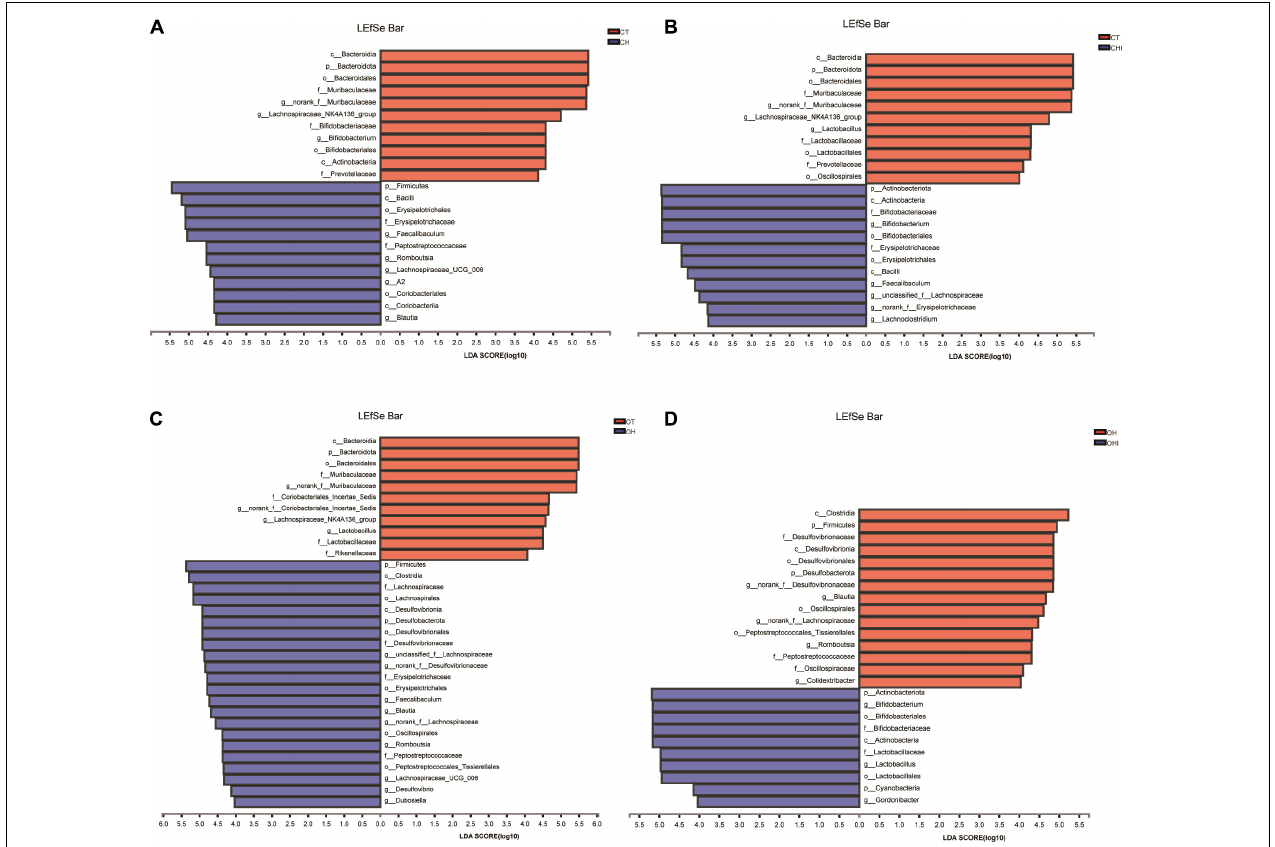
FIGURE 5 | Linear discriminant analysis (LDA) compared the alterations in cecum microbiome according to the diet and genotype. (A) The effect of species abundance on the difference in CT and CH. (B) The effect of species abundance on the difference in CH and CHI. (C) The effect of species abundance on the difference in OT and OH. (D) The effect of species abundance on the difference in OH and